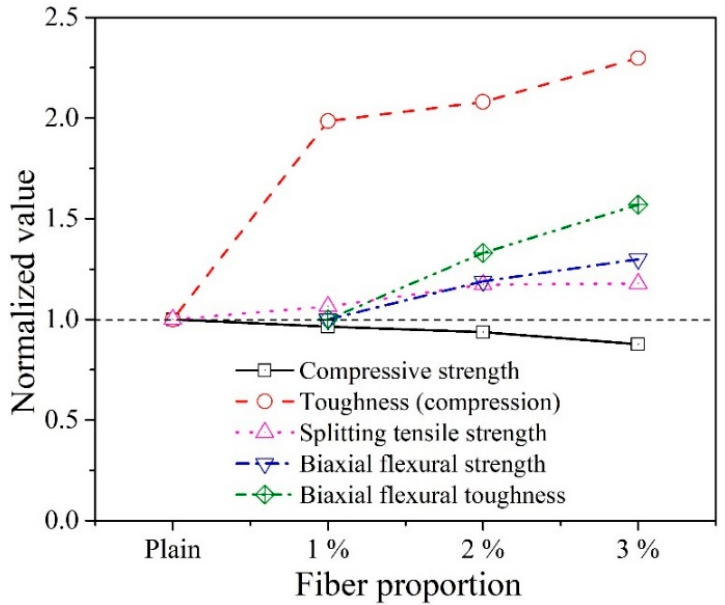
Figure 14. Normalized analysis of strength and toughness based on plain concrete, and biaxial flexural strength and toughness based on 1% WFN fiber-reinforced concrete sample.